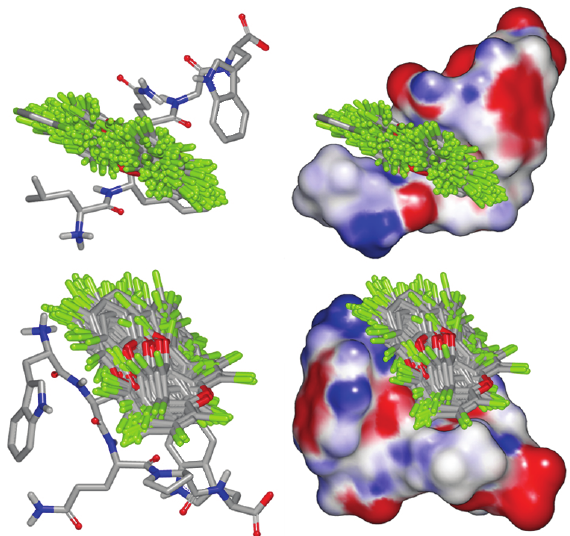
Figure 4: Two examples of pentapeptides versus all 189 ligands. Top: LFQGW folded around ligands with a saddle shaped binding pocket (top right), bottom: WFQPW with an almost planar interaction surface (bottom